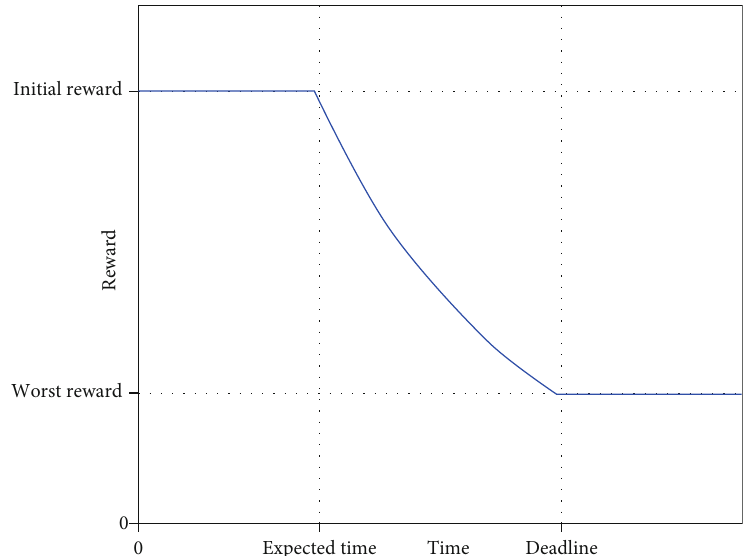
Figure 4: A typical timeliness reward function for one topic which consists of di ff erent observation data units provided by di ff erent satellites. The reward gradually decays as time goes